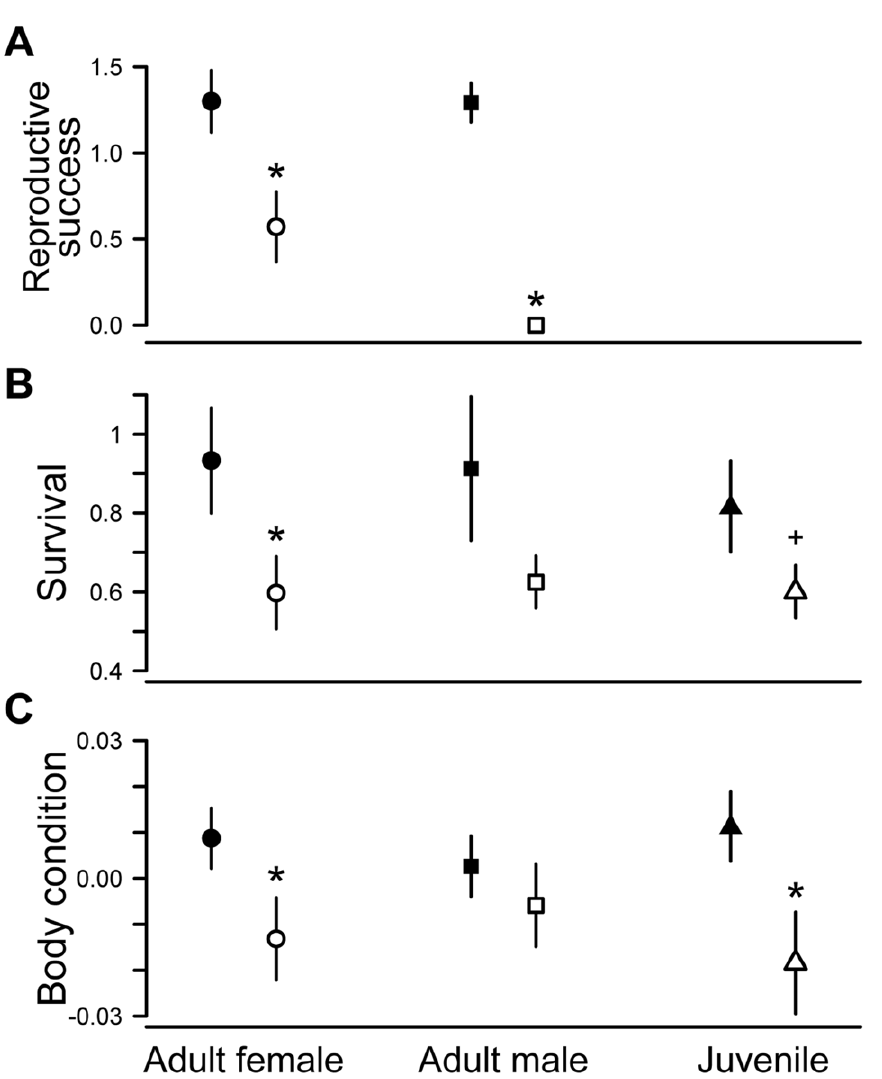
Figure 1. Fitness comparisons of aggregated and solitary night lizards. Higher fitness of aggregated (filled symbols) versus solitary (open symbols) lizards shows clear adaptive benefits to winter aggregation (circles = females, squares = males, triangles = juveniles). ( A ) Reproductive success ( # offspring) of lizards that were aggregated or solitary in the winter directly preceding summer reproduction ( N F =34, N M =24; see text). ( B ) Multi-state model estimates of survival associated with aggregated and solitary social states ( N F =723, N M =443, N J =1166). ( C ) Body condition (residual mass on body size) of all winter-collected lizards by aggregation state ( N F =640, N M =389, N J =507). Asterisks and cross denote P , 0.05 and P , 0.1 significance levels, respectively, and error bars are 6